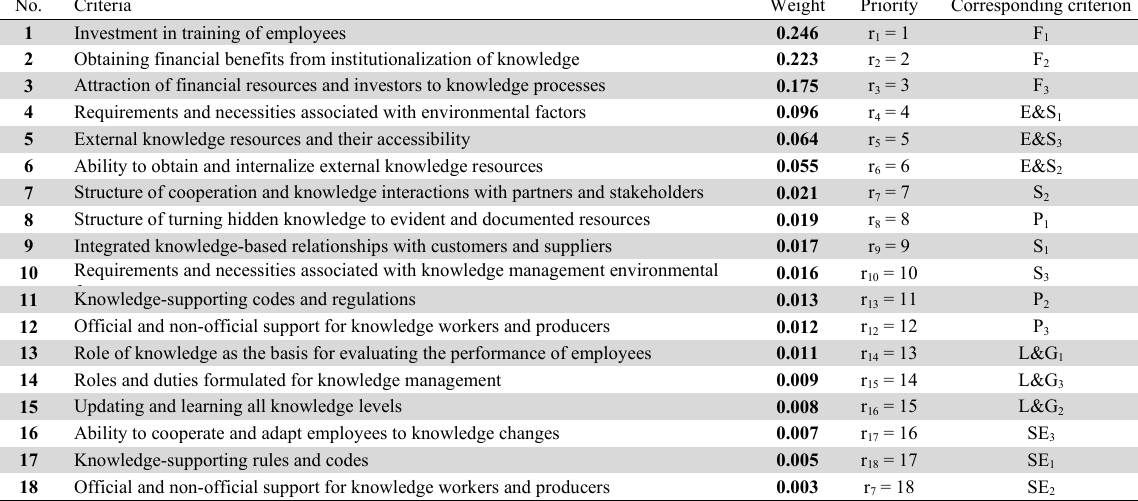
Priority of knowledge management evaluation criteria with DEMATEL No.